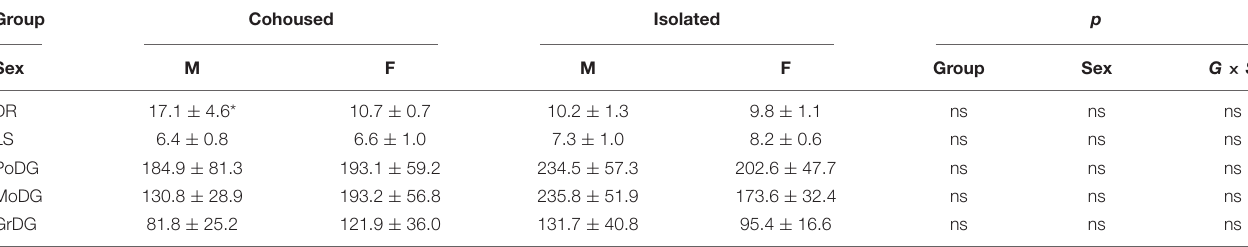
TABLE 1 | Iba-1 cell density (cell/100 µ m 2 ) in various brain regions. Group Cohoused Isolated p Sex F